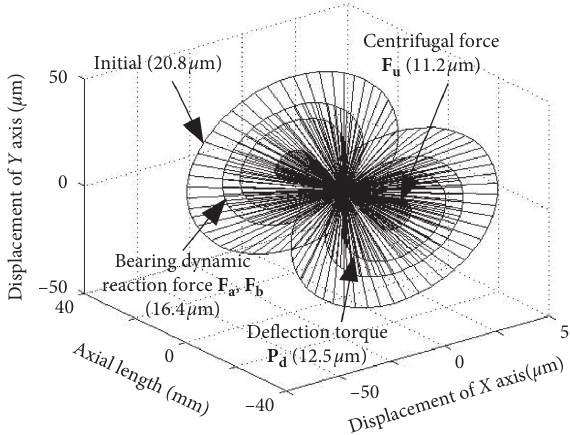
Figure 6: The rotor vibration trajectories.